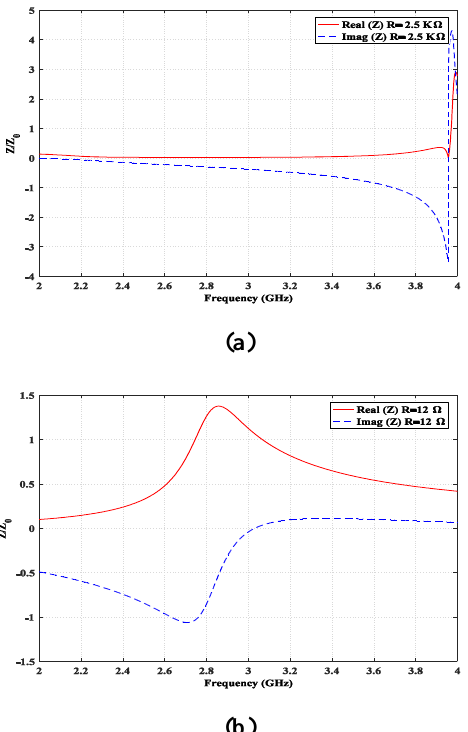
Figure 5: Real and imaginary parts of the structure’s intrinsic impedance at two reflection (a) and transmission (b) states.